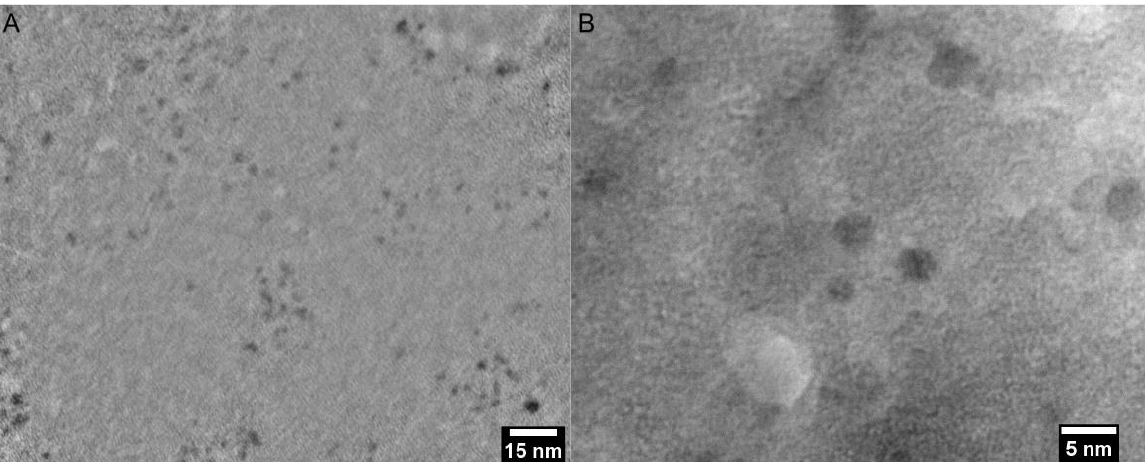
Figure 10. TEM image of the as-synthesized CQDs. 200k magnification image of the as-prepared CQDs ( A ) and ×600k magnification image ( B ).